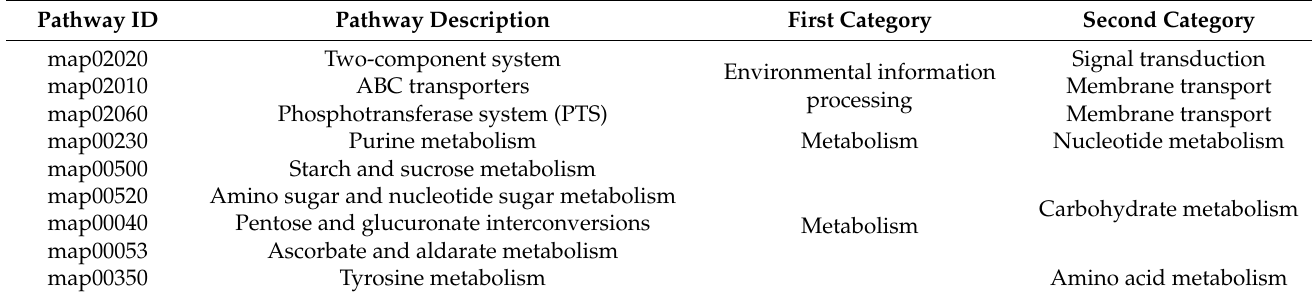
Table 1. Integrated KEGG enriched pathways based on multi-omics